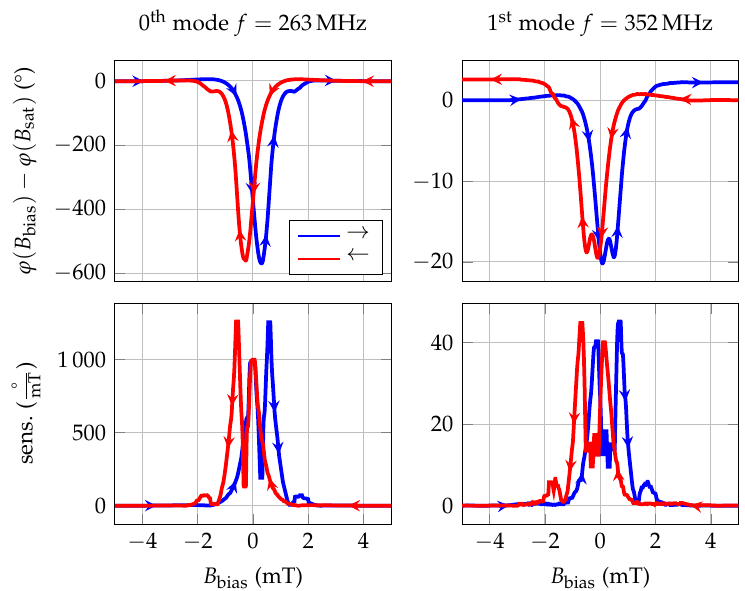
Figure 2. Experimental phase change and sensitivity derived from phase change for 0th and 1st order mode of a delay-line SAW sensor with IDT pitch p = 12µm, guiding layer thickness h GL = 4.5µm and magnetostrictive layer thickness h MS = 200nm. The arrow marks represent the direction of the magnetization process starting from a magnetically saturated state. The phase of the sensor in the magnetically saturated state is chosen as phase reference for the